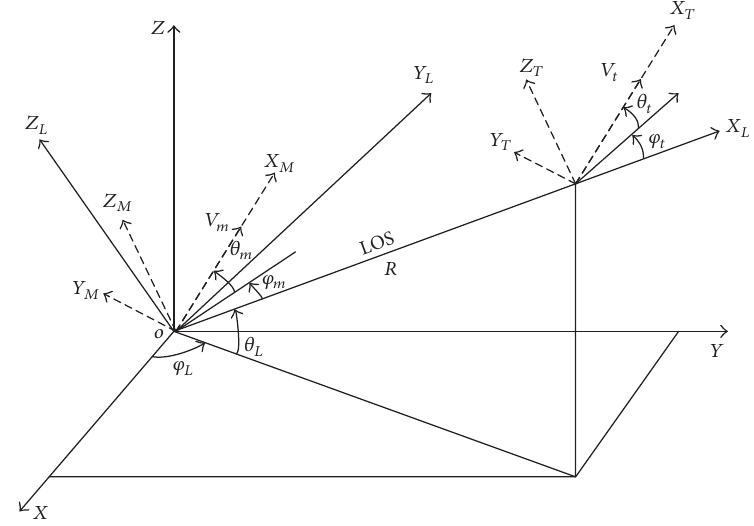
Figure 1: Pursuit geometry in 3-dimensional